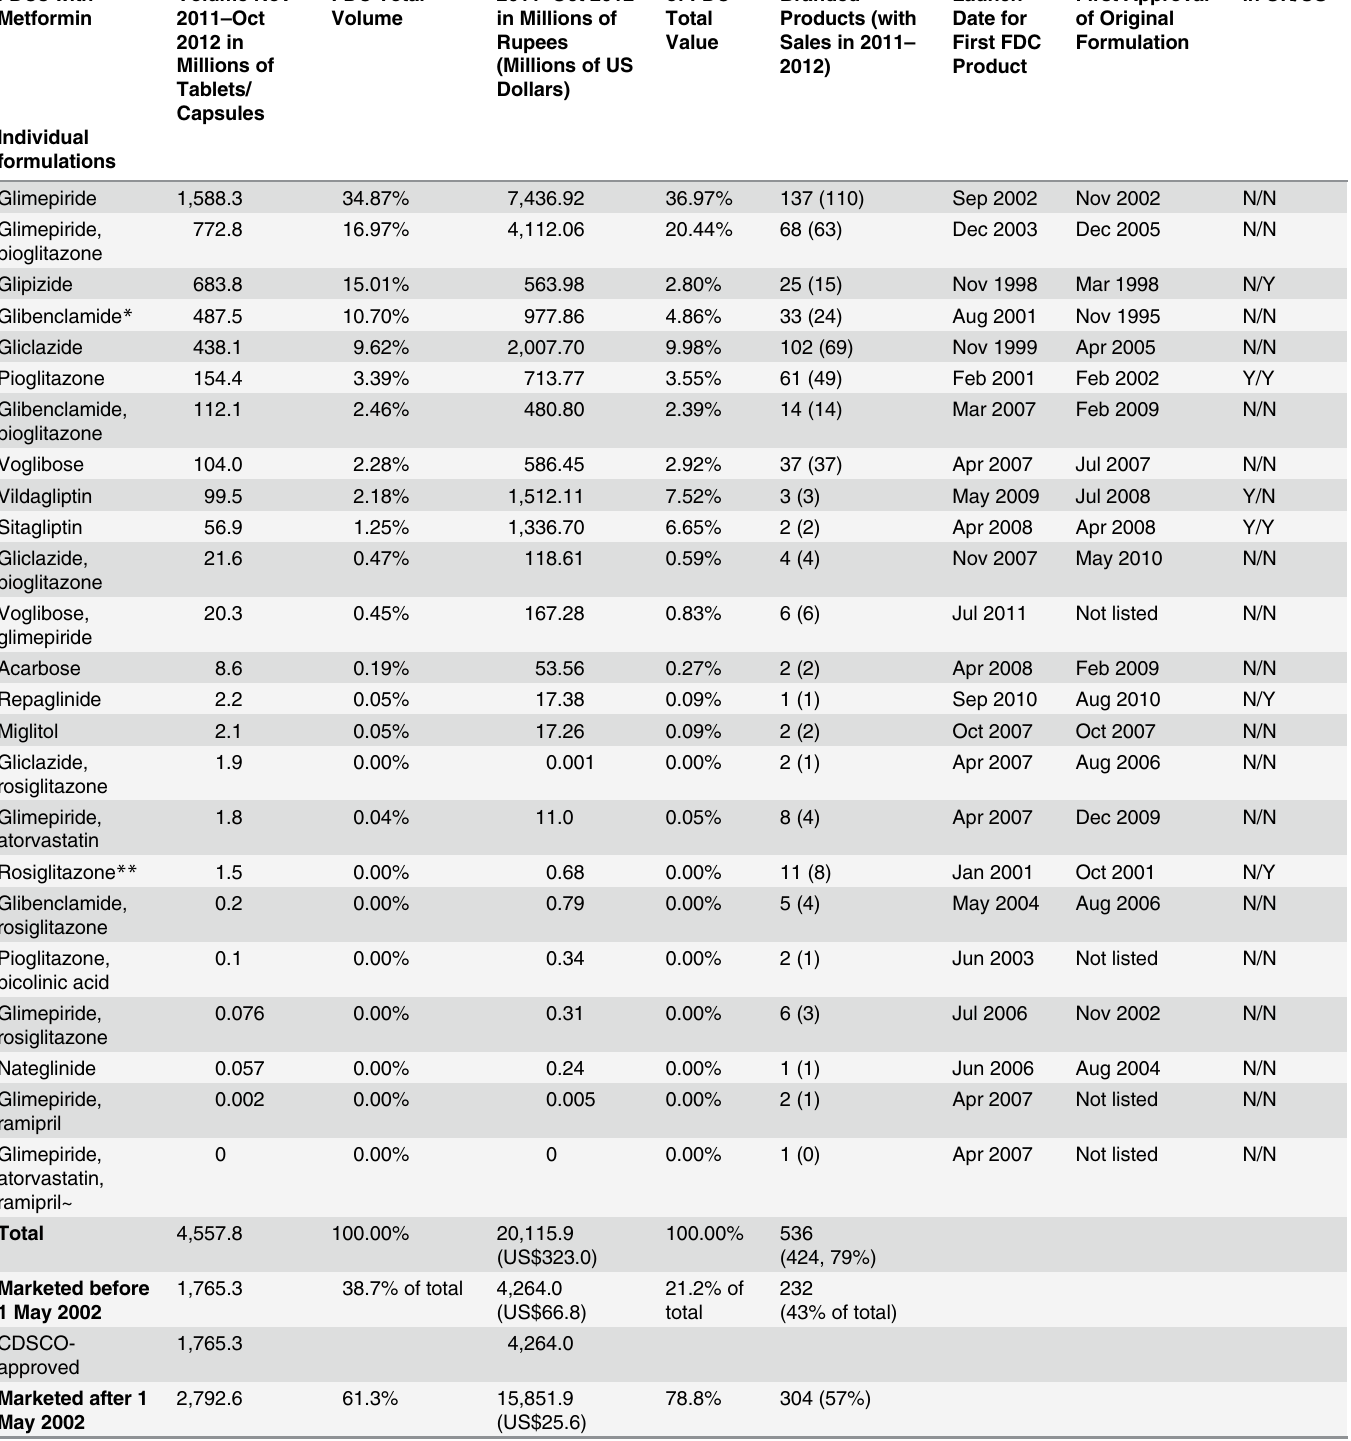
Table 2. Metformin FDC formulations marketed in India. Formulations of FDCs